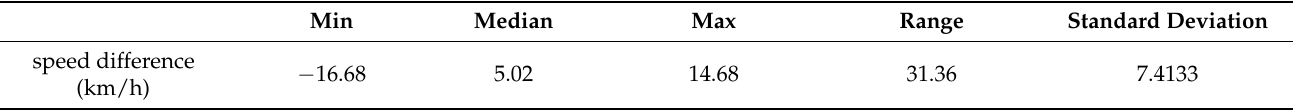
Figure 21. Spatial speed difference in uncontrolled period. ( a ) Spatial Speed Difference in Uncon- trolled Time Period; ( b ) Spatial Speed Difference Distribution Histogram in Uncontrolled Time Period. Table 13. Results of space speed difference